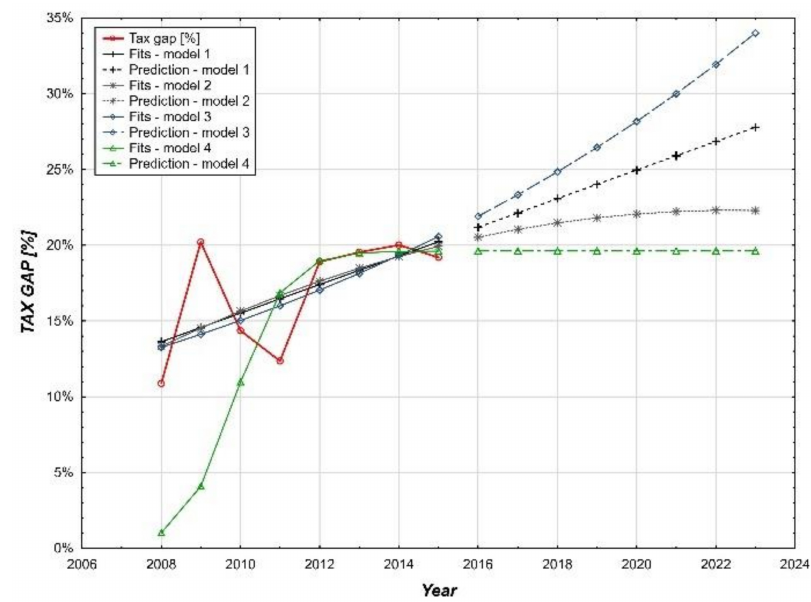
Figure 10. Predictive values of TAX GAP (%) in the years